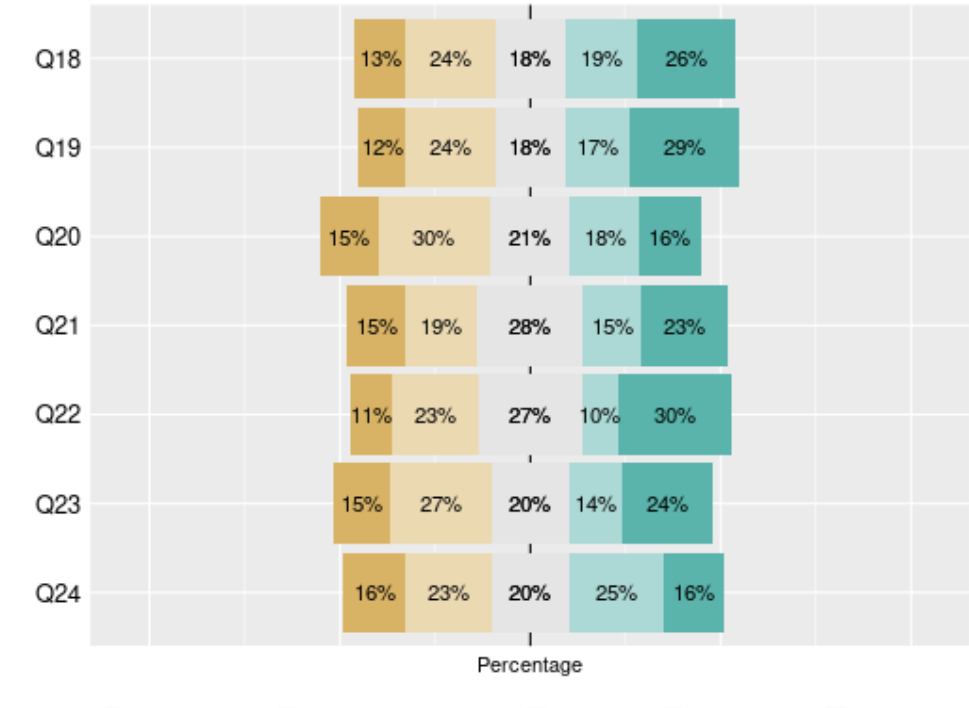
Figure 4. Results related to the Legal compliance dimension and with respect to the General Data Protection Law (LGPD)